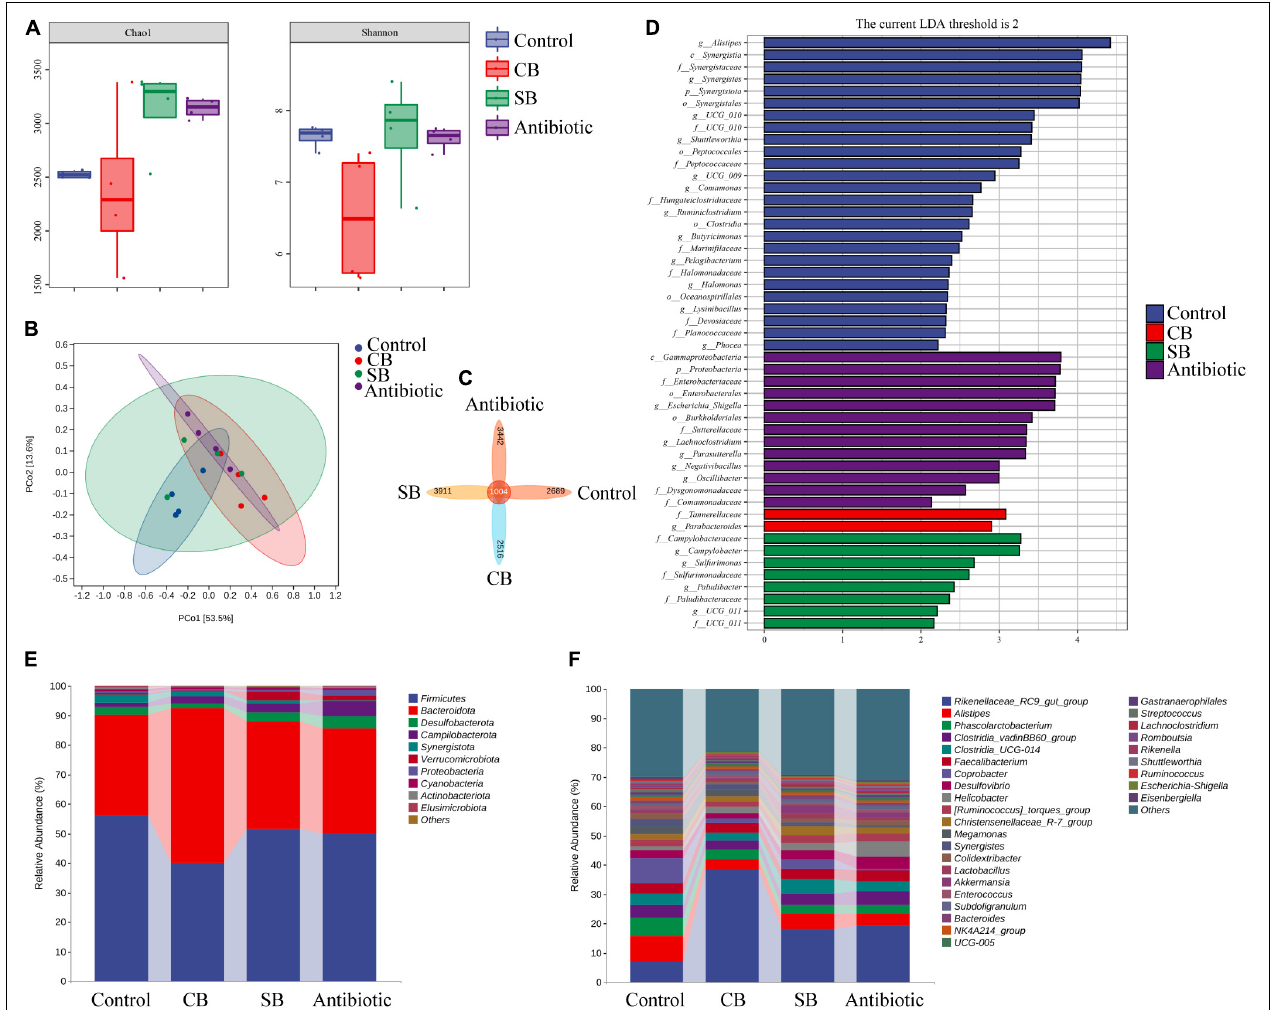
FIGURE 3 | Effects of different feed additives on caeca microbial community. (A) Alpha diversity was assessed by Chao1 and Shannon indexes. (B) Principal coordinates analysis (PCoA) based on UniFrac distance. (C) OTU Venn diagram. (D) Linear discriminant analysis (LDA) scores for various taxa abundances. (E) Microbial composition at the phylum level is shown as relative abundance. (F) Microbial composition at the genus level is shown as relative abundance.